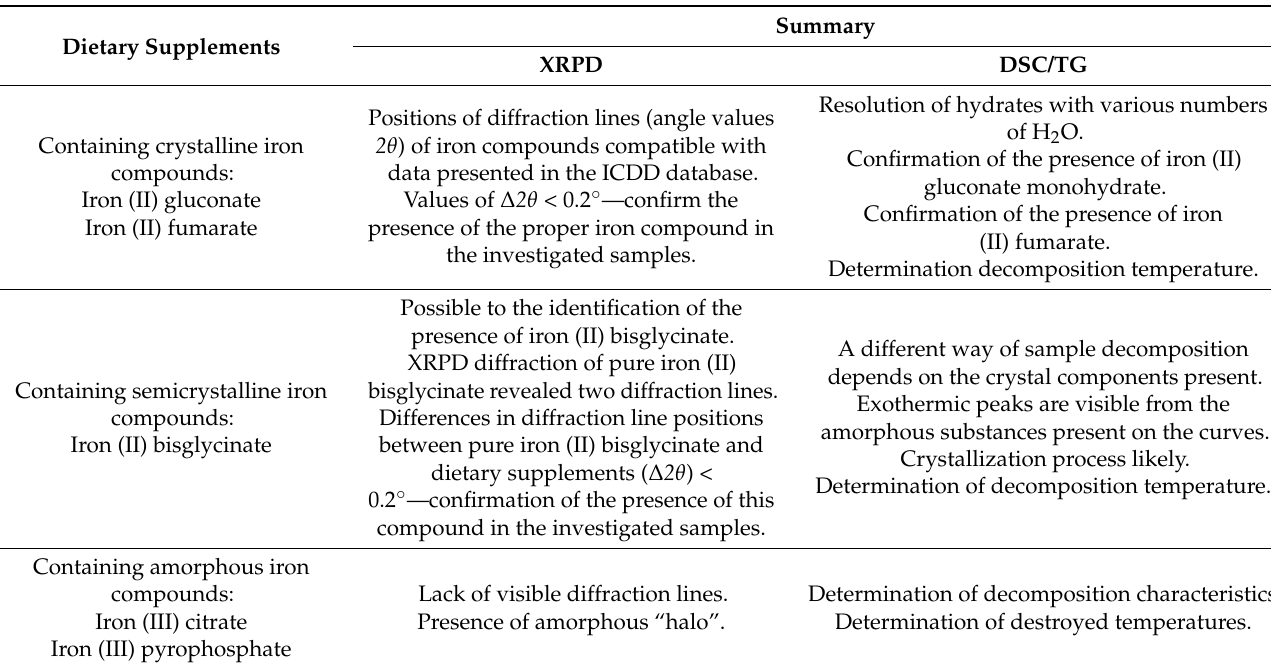
Table 12. Summary of results of both